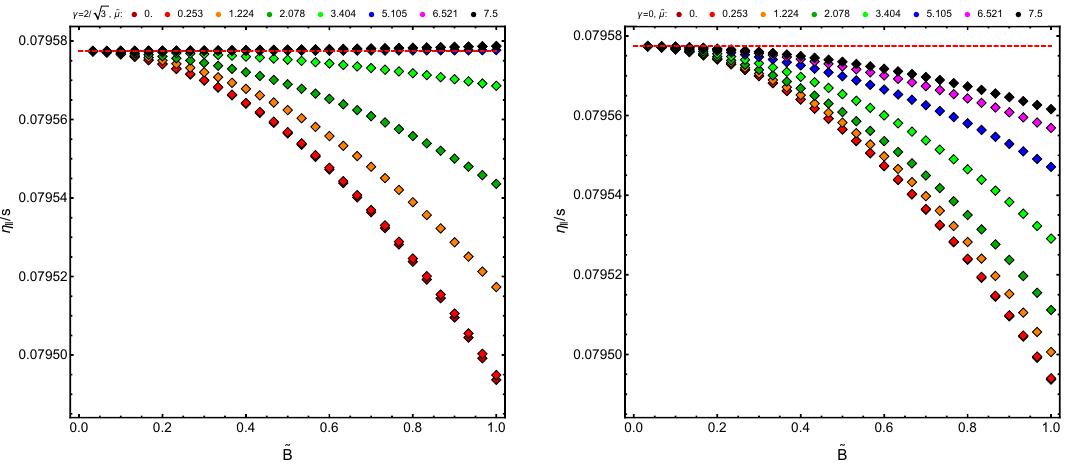
˜ Figure 9 . Parallel shear viscosity as function of B for fixed values of ˜ µ . The dashed red line √ indicates the well-known result for η , namely 1 / (4 π ) . Left: γ = 2 / 3 . For this supersymmetric ⊥ /s value of γ , the ratio of parallel shear viscosity increases with ˜ B for ˜ µ ≥ 5 within the range of parameters displayed here. See figure 10 for a refined statement. Right: γ = 0